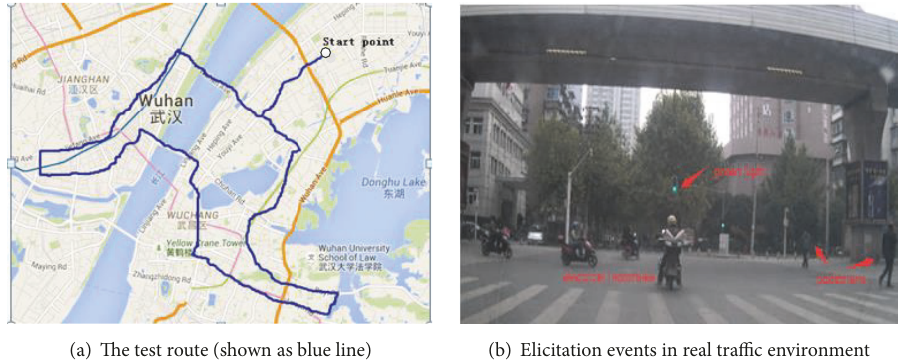
Figure 2: The test route and traffic environment of field experimental system